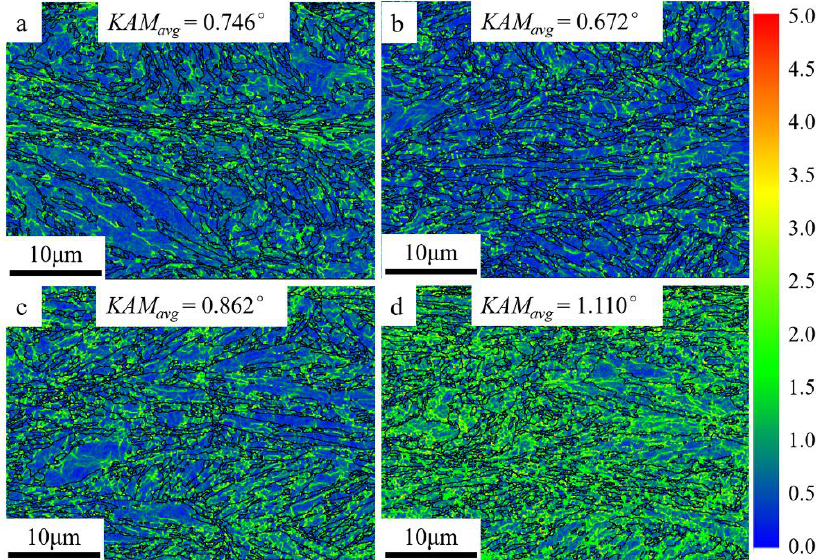
Figure 6. The KAM maps of the forged tube with a reduction of 42.7%: ( a ) r = 11.0 mm; ( b ) r = 8.3 mm; ( c ) r = 5.6 mm; ( d ) r = 2.9 mm.